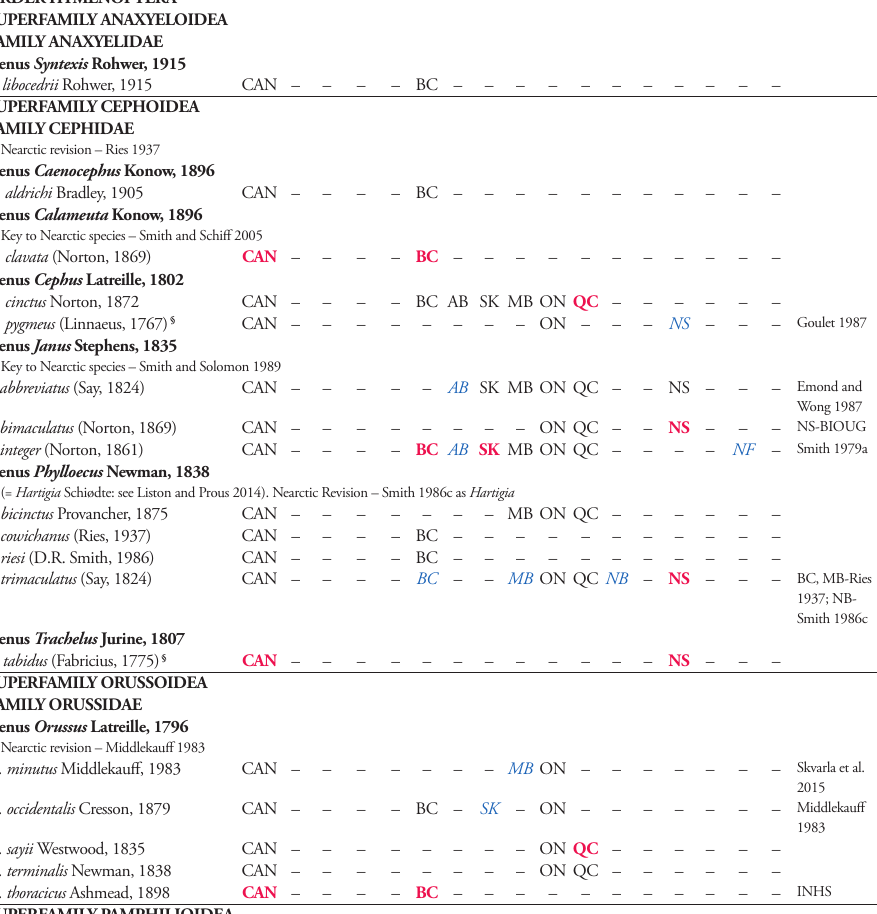
Table 2. Checklist of described species of sawflies of Canada, Alaska and Greenland. See Methods for description of acronyms of regions and Fig. 1 for their locations. Black, regular font records are previ- ously published and a specimen has been examined. Red, boldface records are new (unpublished) and a specimen has been examined. All specimens examined are deposited in the CNC, except if a deposi- tory acronym is noted in the far right column. Blue, italicized records are previously published but no specimen has been examined. Literature references are only noted for italicized records. For species with multiple italicized records based on multiple references, the references are listed in order from left to right, corresponding with the distributional records depicted from left to right, unless otherwise noted. An asterisk (*) denotes a record that was collected prior to the establishment of Nunavut or Labrador, and it is uncertain whether the record is from the Northwest Territories or Nunavut, or from the island of Newfoundland or Labrador, respectively. § indicates a species that has been introduced from outside of North America in the last 500 years and has established a